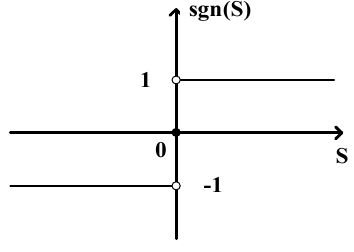
Figure 8. Symbolic function sgn ( s ) .